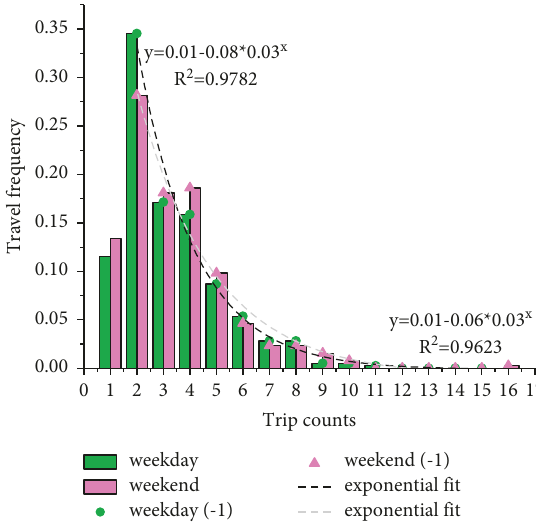
Figure 10: Trip number distributions and fits on the weekday and weekends. Table 13: Comparison of the trips number between the weekday and weekend.